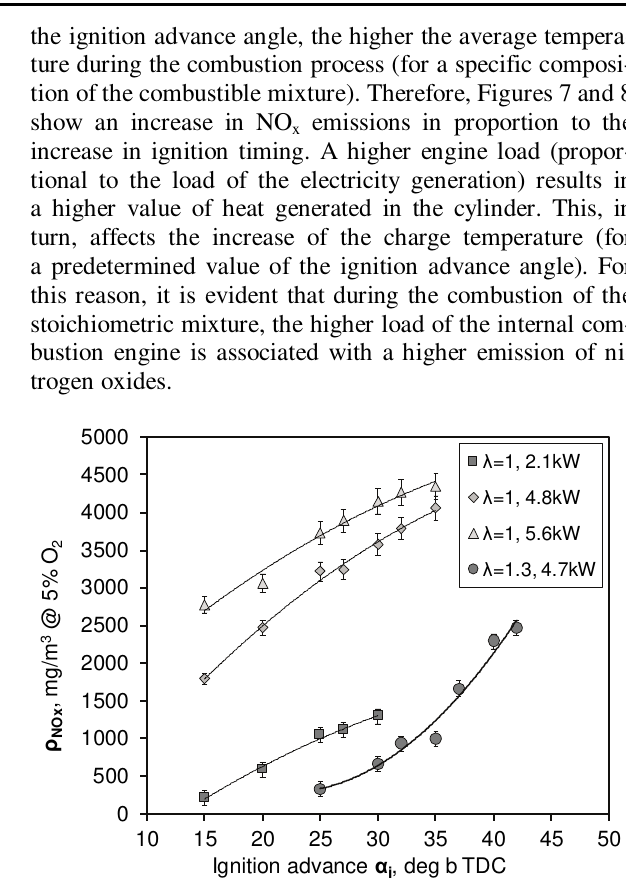
Fig. 9. NO x concentration adjusted to 5% of O 2 in dry exhaust vs ignition timing, throttle position and mixture composition